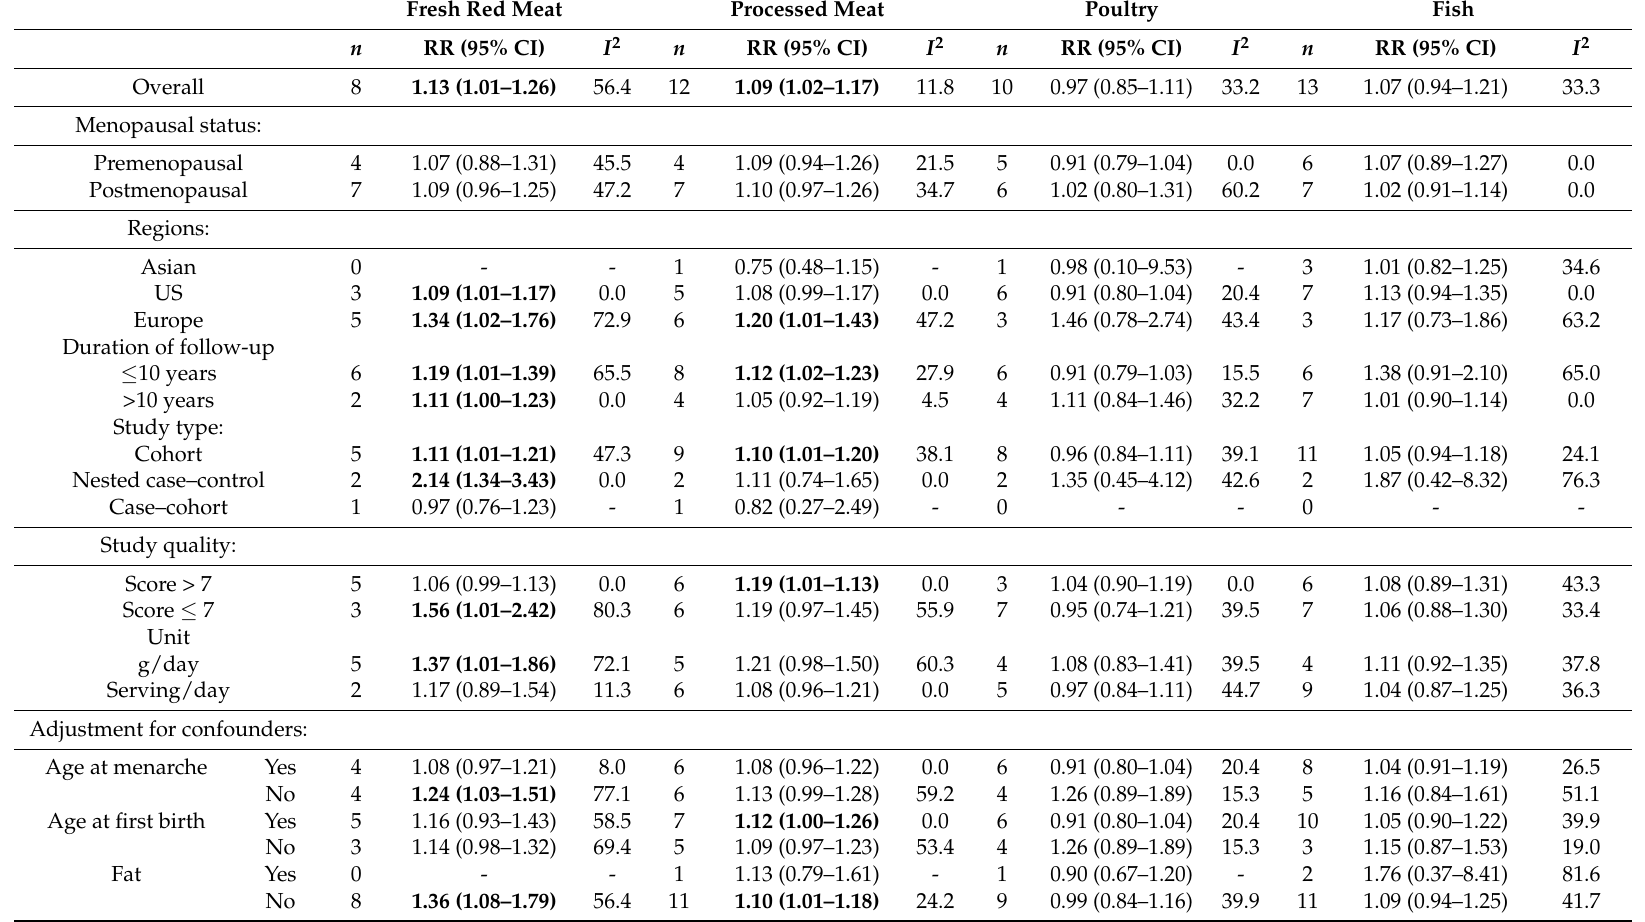
Table 3. Subgroup analysis of dietary protein sources intake and risk of breast cancer: dose-response